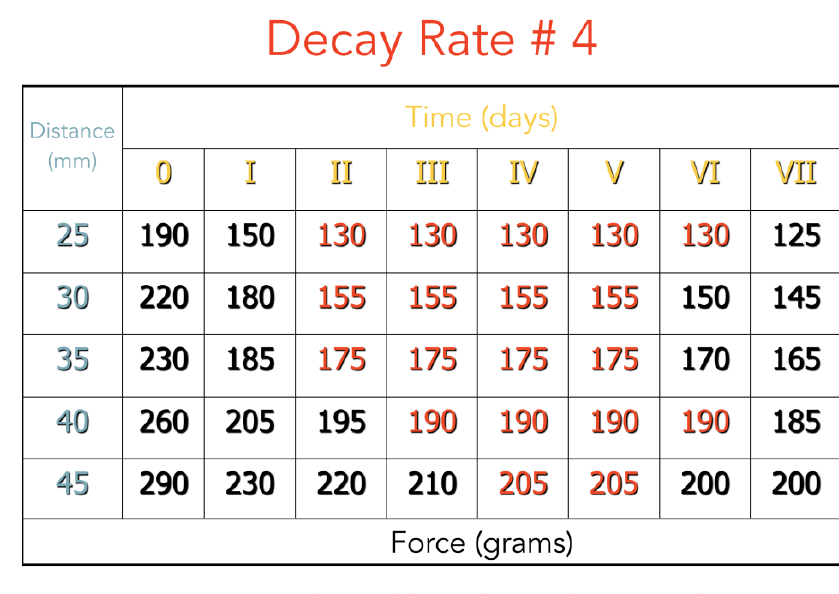
Figure 9. Force delivered by an elastic #4 during a week.